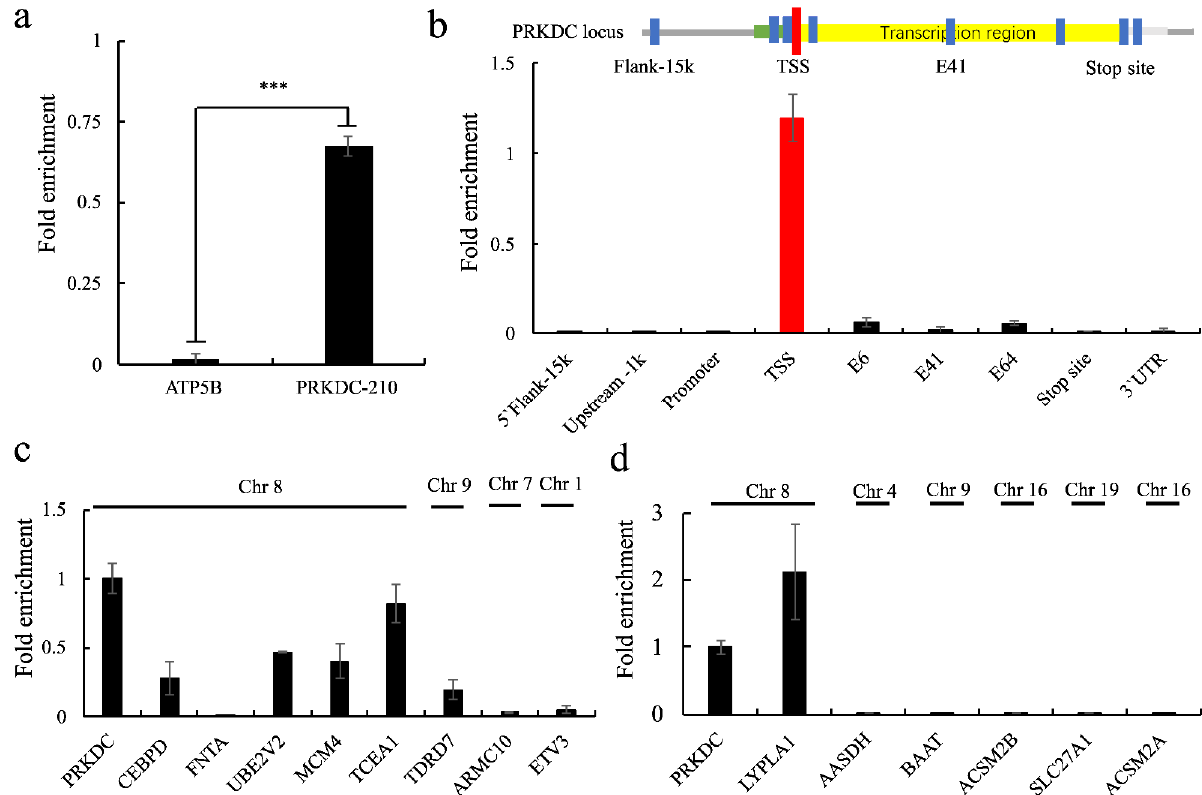
Figure 4. MFC7 was used for all ChIRP assays. ( a ) RT-qPCR analyses of PRKDC-210 and ATP5B (negative control) levels in the RNA precipitated by ChIRP. ( b – d ) The DNAs associated with the immunoprecipitated RNAs in the ChIRP assay were analyzed by qPCR using specific primers. ( b ) The distribution of PRKDC-210 at the PRKDC locus. ( c ) Enrichment of PRKDC-210 at the TSSs of various genes. ( d ) Enrichment of PRKDC-210 at the TSSs of genes related to fatty acid metabolism. Data in all panels are represented as the mean ± s.e.m. of three independent experiments. *** p < 0.001 by a two-tailed Student’s t -test.